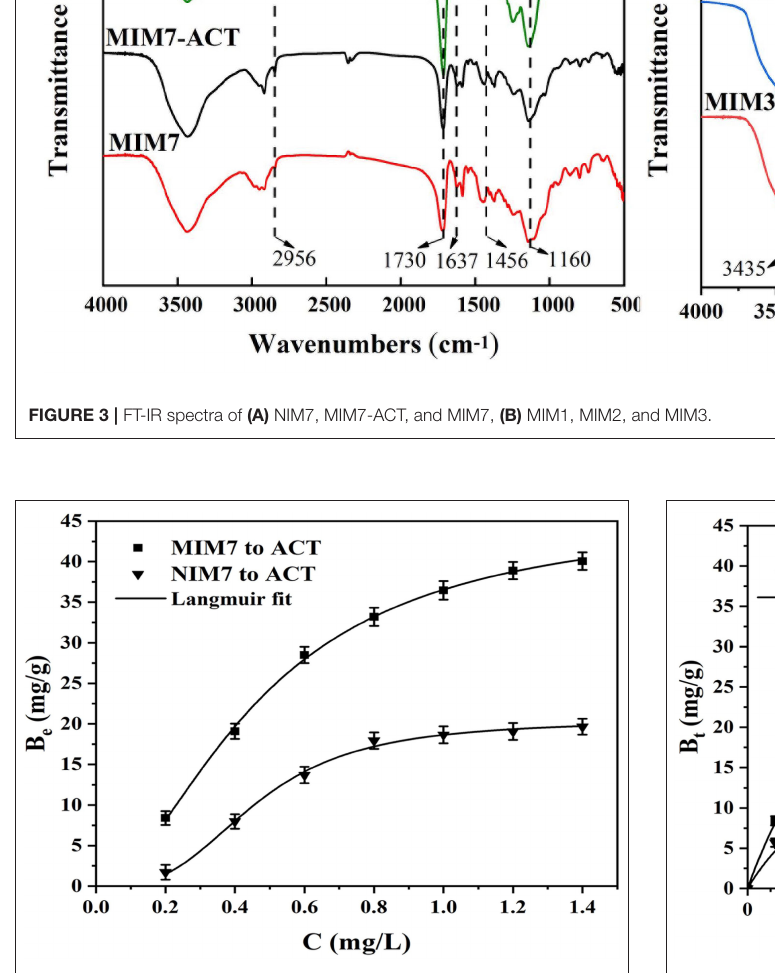
FIGURE 4 | Equilibrium data and Langmuir modeling for the adsorption of ACT onto MIM7 and NIM7.